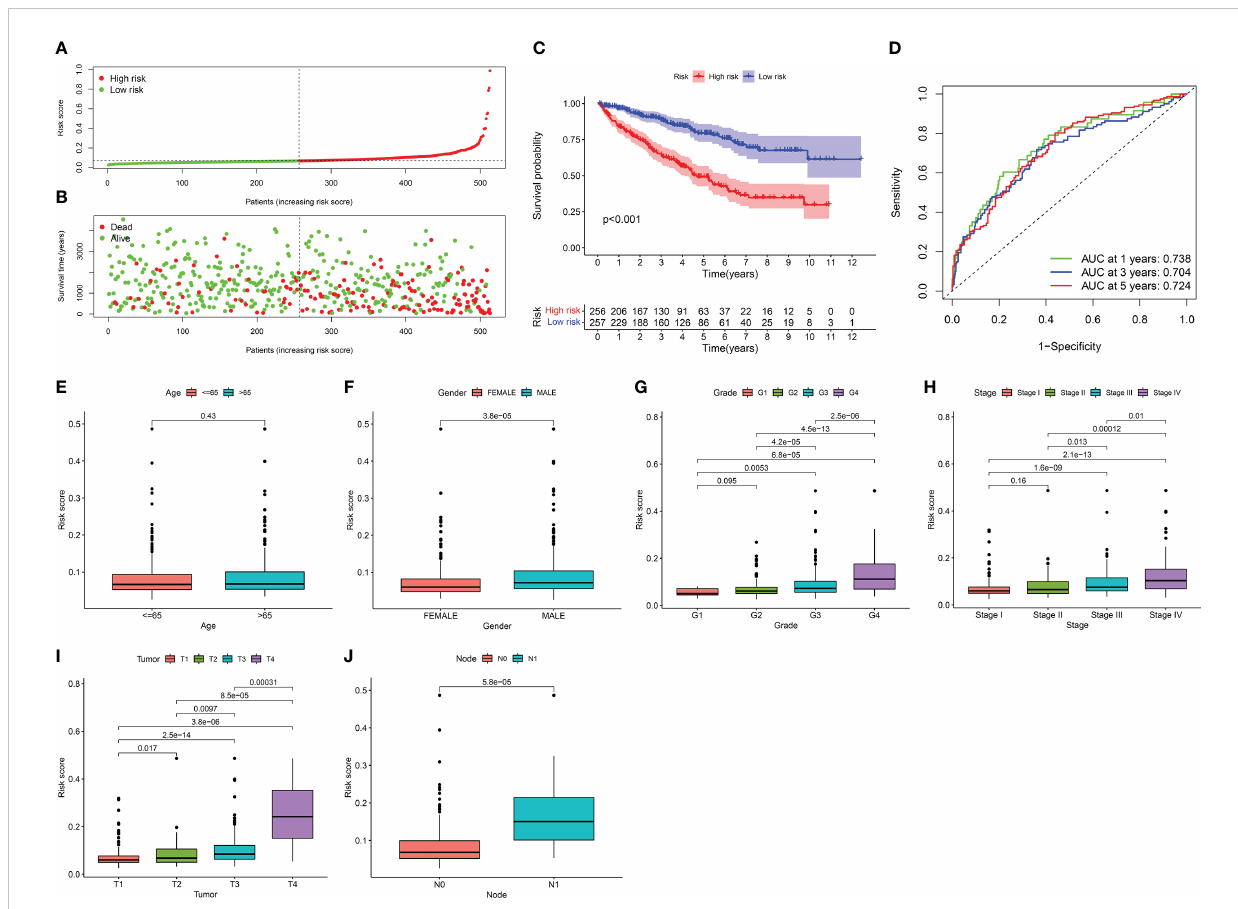
FIGURE 6 Clinical signi fi cance of risk signature for KIRC patients. (A) Distribution of risk scores to be divided into high- and low- risk groups. (B) Distribution of the OS to depict the relationship between OS and risk signature in dead and alive KIRC patients. (C) Kaplan-Meier survival analysis of risk signature. (D) AUC in ROC analysis for risk signature at 1 ‐ , 3 ‐ and 5 ‐ years survival. When AUC is greater than 0.7, the prediction model has reliable accuracy. (E – J) Boxplot reveals the relationship between risk signature and clinical information, containing in age, grade, tumor stage, tumor, lymph node and metastasis